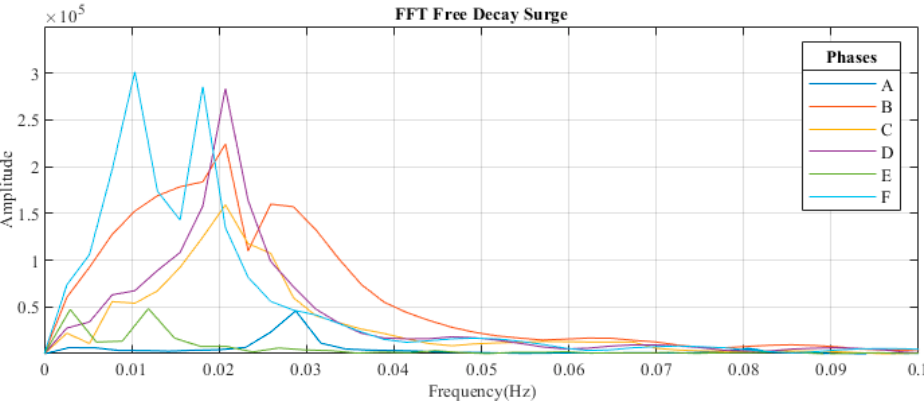
Figure 8. FFT of free decay of surge motion for all phases of testing.